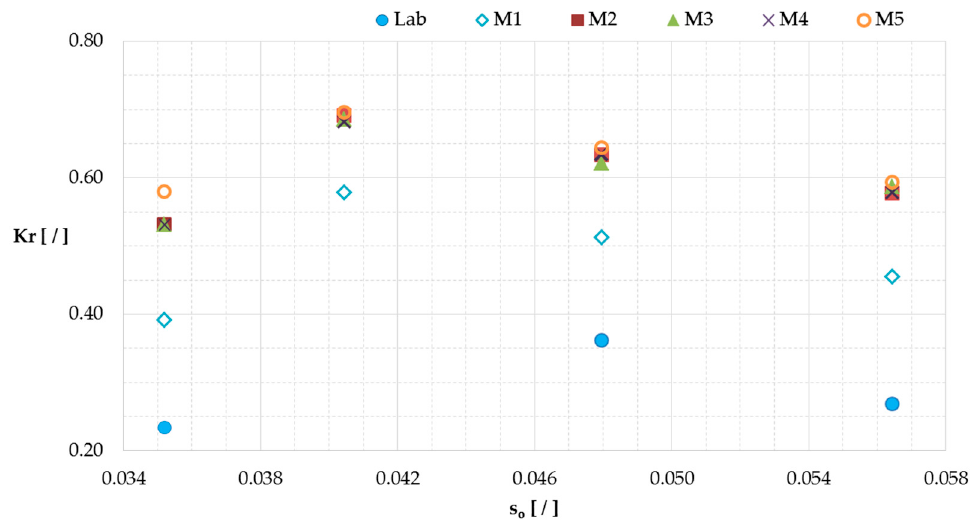
Figure 8. A comparison of the values of K r for the M1–M5 configurations, under normal conditions only (Table 1).